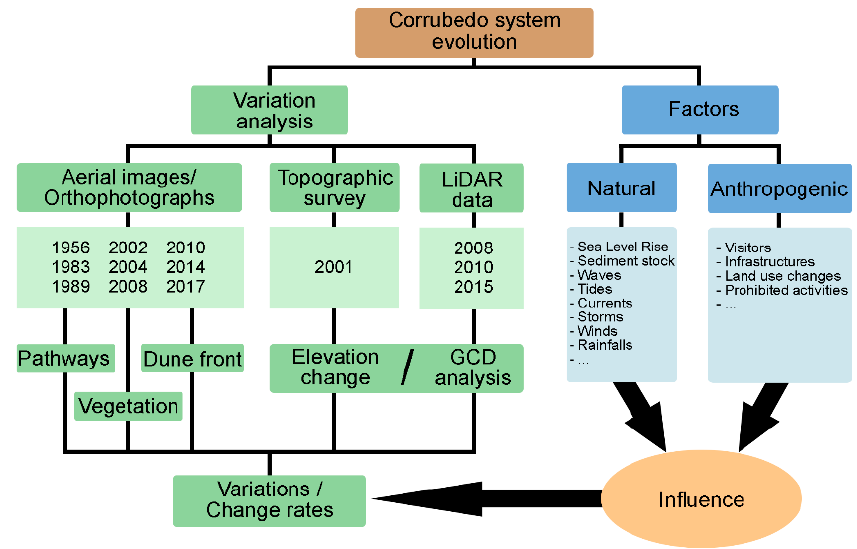
Figure 3. Flowchart with the materials and steps of variation analysis and the main elements that could be influencing in the analyzed sector behavior.